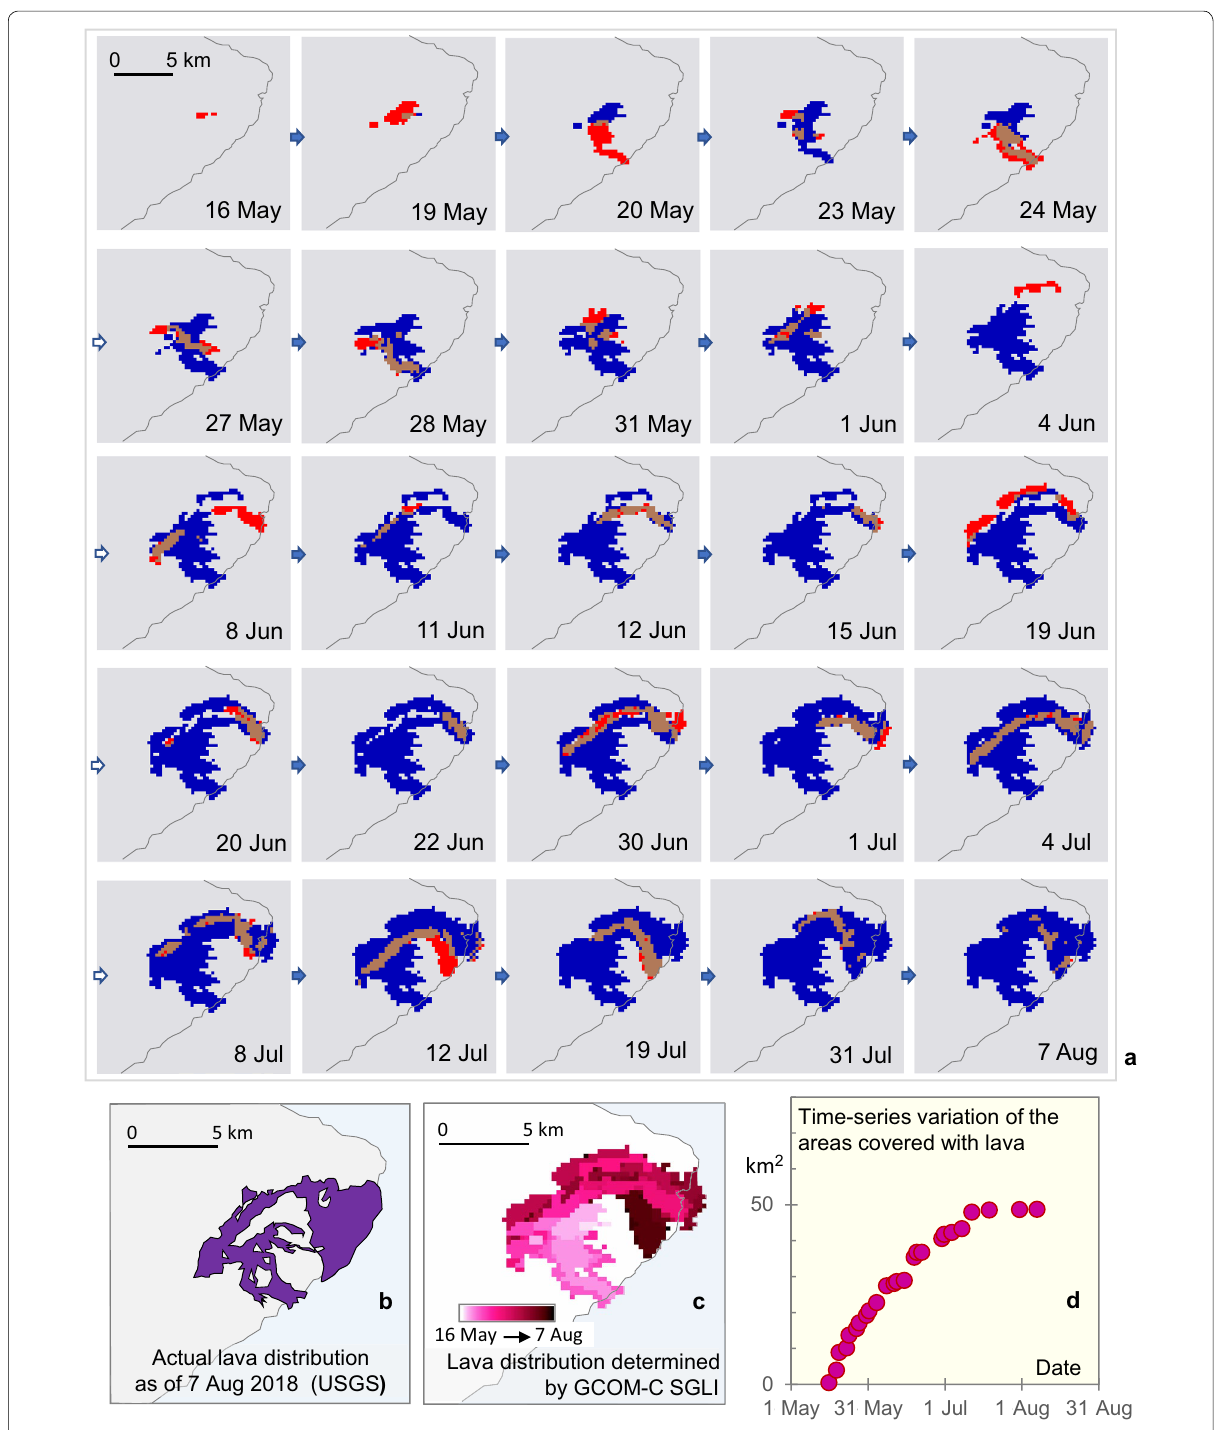
Fig. 3 a Cumulative thermal anomaly map of the 2018 Kilauea lava flows produced from a series of SGLI images. Red: Newly effused active lava on the original ground surface; Brown: Newly effused active lava on the settled 2018 lava; Blue: Settled 2018 lava; Light Gray: Original ground surface. b Actual lava distribution on 7 August 2018, as reported by USGS (USGS 2018). c Temporal change in the distribution area of the lava flows based on the cumulative thermal anomaly maps. d Temporal variation in the area covered by lava flows based on the cumulative thermal anomaly